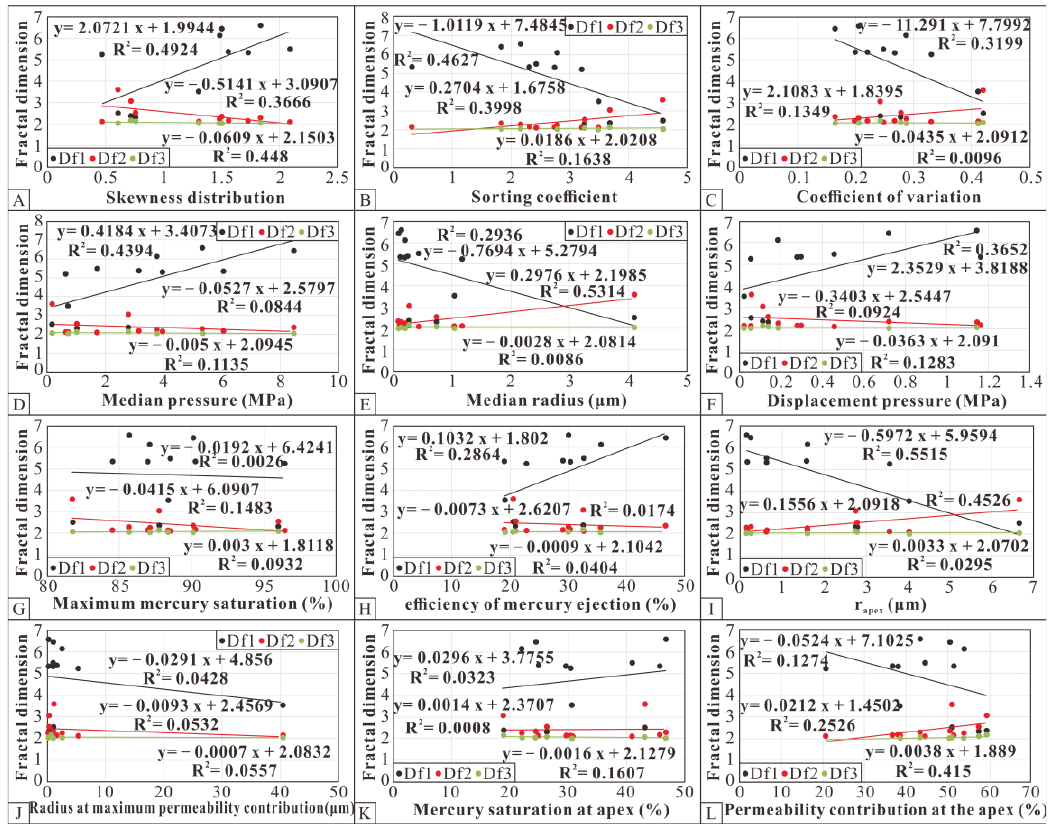
Figure 20. Correlation between fractal dimension and pore-throat structure parameters. ( A ) Correlation between skewness distribution and fractal dimension. ( B ) Correlation between sorting coefficient and fractal dimension. ( C ) Correlation between coefficient of variation and fractal dimension. ( D ) Correlation between median pressure and fractal dimension. ( E ) Correlation between median radius and fractal dimension. ( F ) Correlation between displacement pressure and fractal dimension. ( G ) Correlation between maximum mercury saturation and fractal dimension. ( H ) Correlation be- tween efficiency of mercury ejection and fractal dimension. ( I ) Correlation between r apex and fractal dimension. ( J ) Correlation between radius at maximum permeability contribution and fractal di- mension. ( K ) Correlation between mercury saturation at apex and fractal dimension. ( L ) Correlation between permeability contribution at the apex and fractal